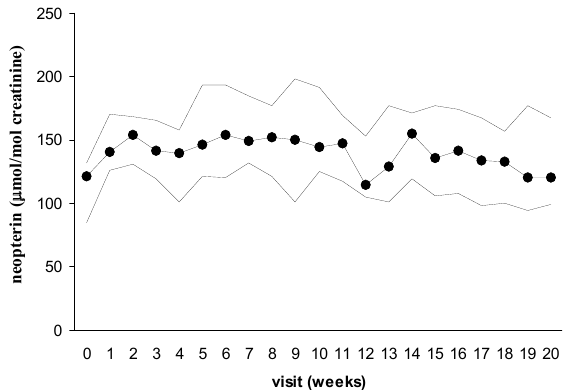
Figure 2. Urinary neopterin during dose-dense chemotherapy. Shown are the medians of urinary neopterin concentrations obtained in weekly intervals during the chemotherapy with 95 % confidence inter- vals indicated by the dashed line. Compared to base- line, urinary neopterin was significantly (p < 0.05) increased at every subsequent visit with the exception of visit 12 and 20 at which the significance was bor- derline (p = 0.06 and p = 0.07, respectively).